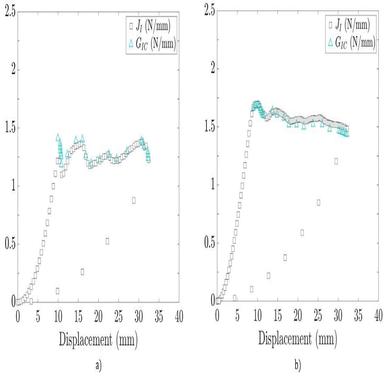
CBT versus J-integral data reduction methods at a displacement rate of 2 mm/min for (a) rigid (T1-03) and (b) flexible (T2-01) adhesives.